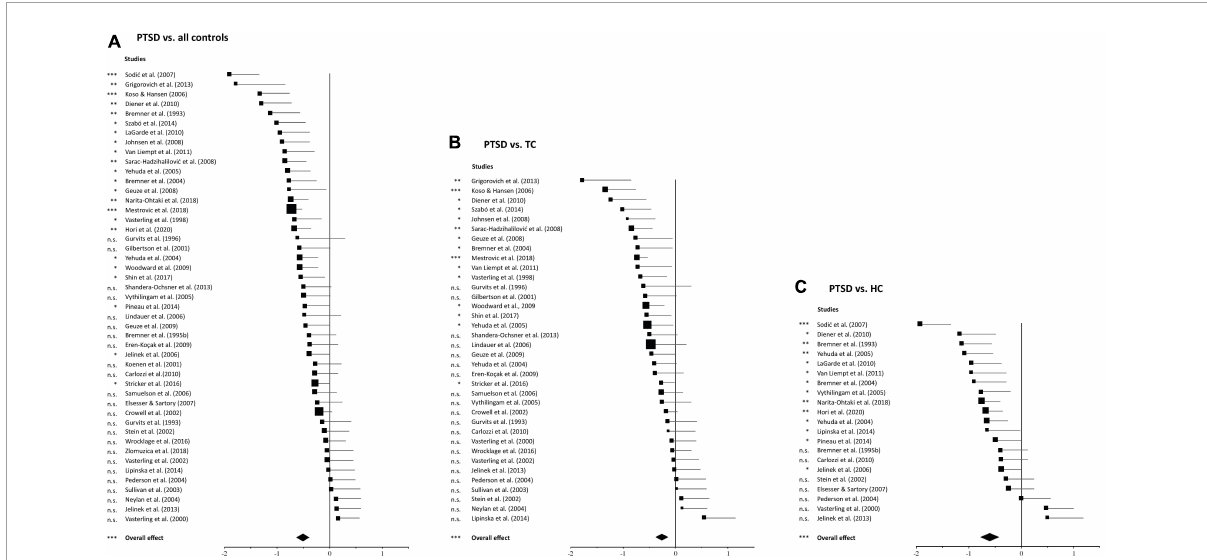
FIGURE2 Forest plots of group comparisons. (A) Comparison of post-traumatic stress disorder patients with all controls, (B) comparison of PTSD patients with traumatized controls, (C) comparison of PTSD patients with non-traumatized healthy controls. Squares in the forest plot represent the individual effect sizes of the primary studies, and square size corresponds to the relative size of the sample studied. For each comparison, the diamond at the bottom indicates the overall effect of the meta-analysis. The width of the diamond and the horizontal lines extending from the squares represent the respective confidence intervals. n.s. abbreviates not significant. ∗ p ≤ 0.05, ∗∗ p < 0.001, ∗∗∗ p < 0.0001.